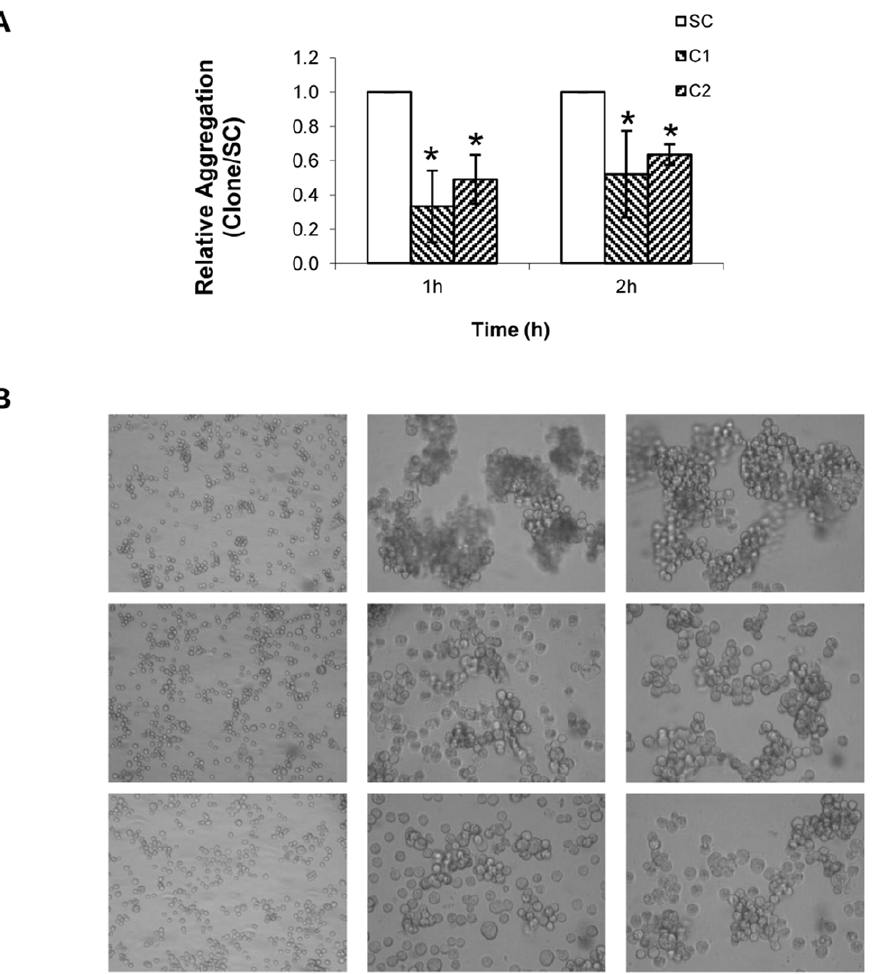
Figure 4. Quantification of cell-cell aggregation. ( A )Quantification of the cell-cell aggregation index in MKN45-C1 and MKN45-C2 and MKN45- SC control. The cell-cell aggregation index was assessed by the observed decrease in the number of isolated cells over time, and normalized to the data obtained with the scrambled control. *P , 0.01; ( B ) Images of the aggregates formed after 1 and 2 hours of constant stirring. First column shows isolated cells at time 0h (20x magnification) and second and third columns show aggregates formed after 1h and 2h of incubation (40x magnification), in MKN45-C1 and MKN45-C2 and MKN45-SC control. (Figure 1A), Western Blot (Figure 1B) and Real-Time PCR (Figure 1C).